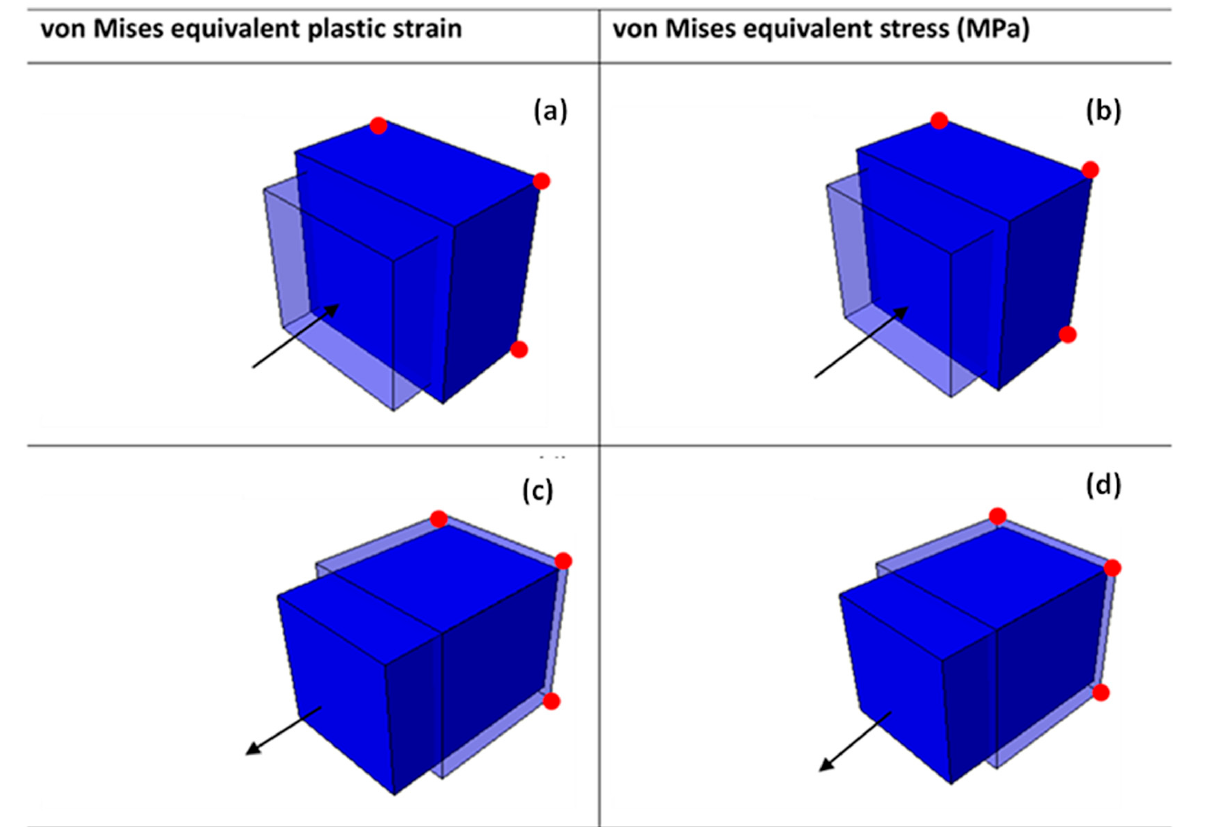
Figure 5. A typical VUMAT deformed 8-node linear brick element at a temperature of 298 K and velocity of 4 m/s in ( a , b ) compression and ( c , d ) tension for sample type C. The arrows show the loading direction, while the red dots are the roller supports.